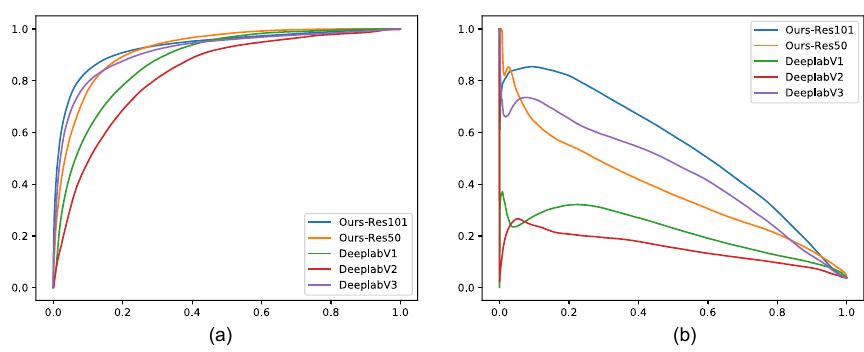
Figure 3. ROC ( a ) and PR ( b ) curves of different methods on the proposed